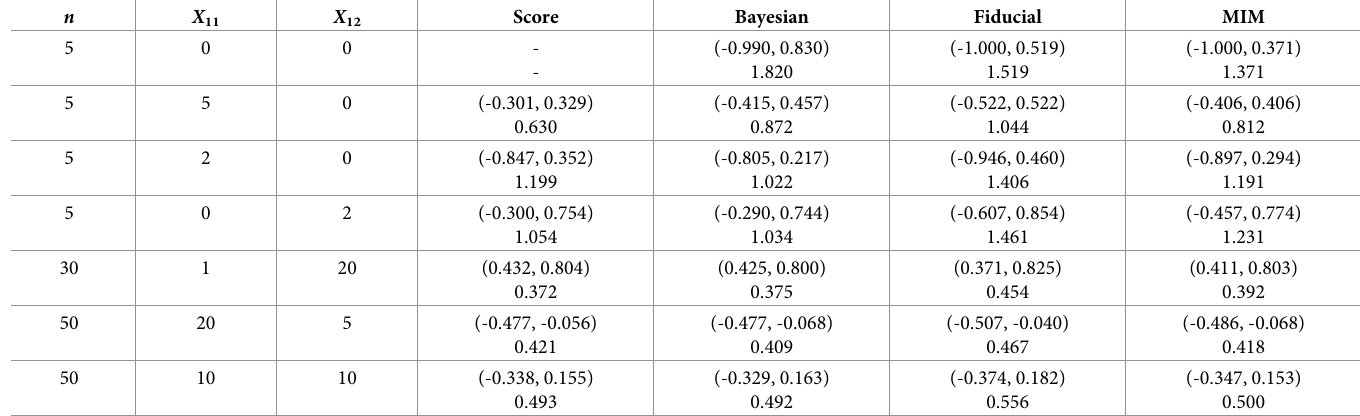
Table 2. The four 95% confidence intervals and widths for the selected combinations of ( n , X 11 , X 12